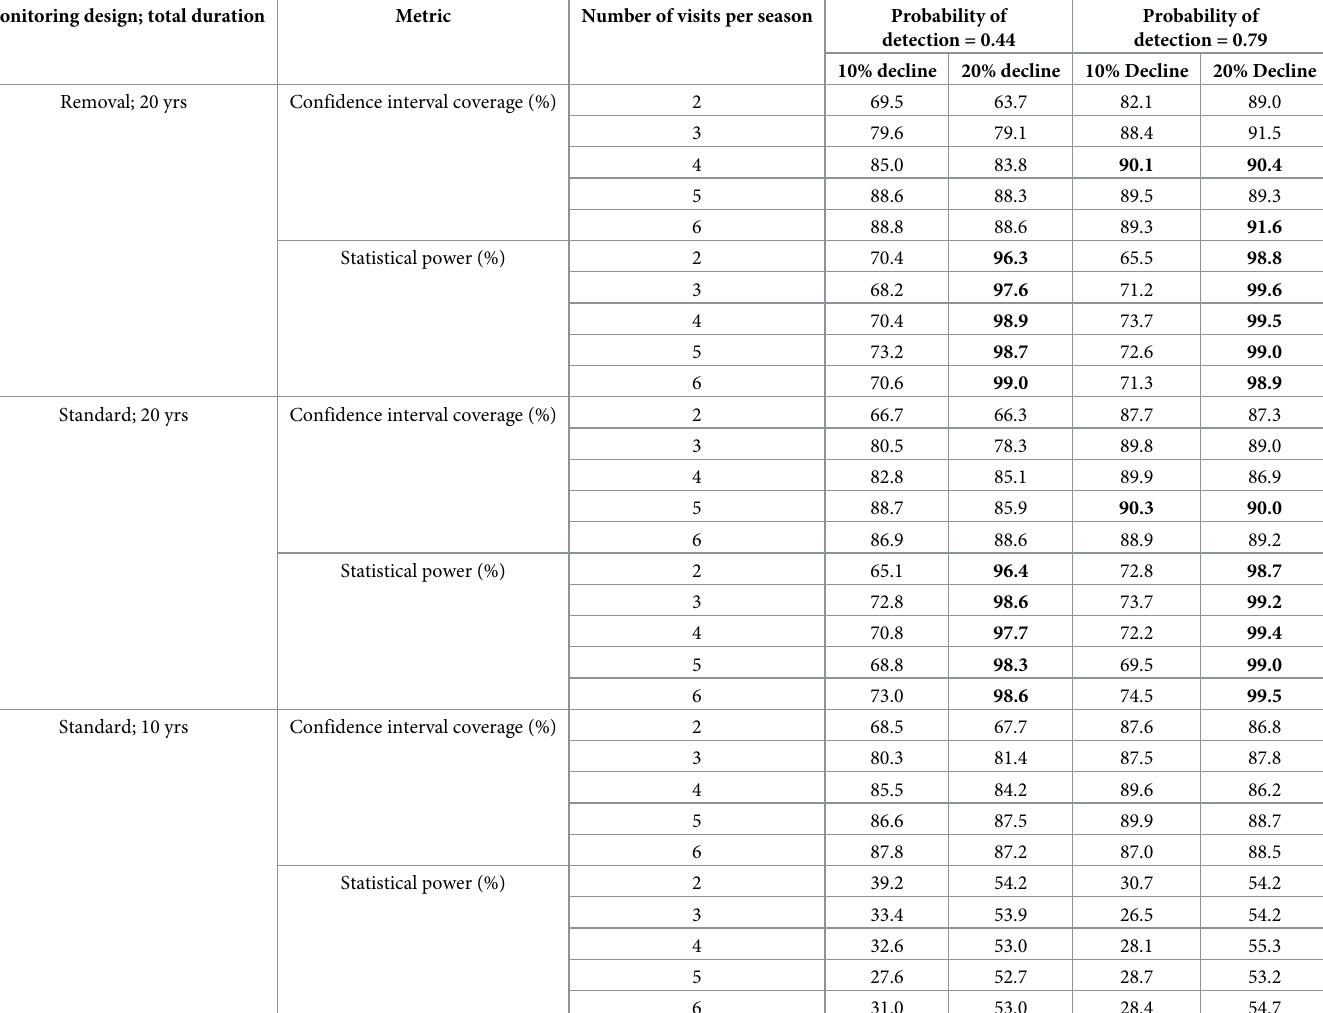
Table 4. Evaluation metrics for simulations increasing number of visits to